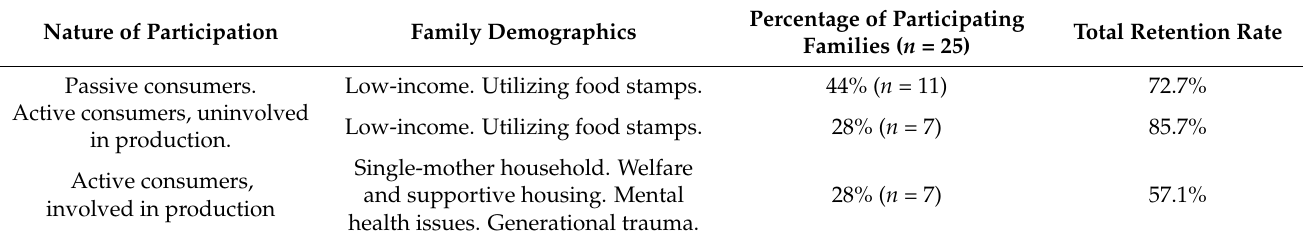
Table 1. Family Characteristics, Participation, and Retention by Nature of Participation.